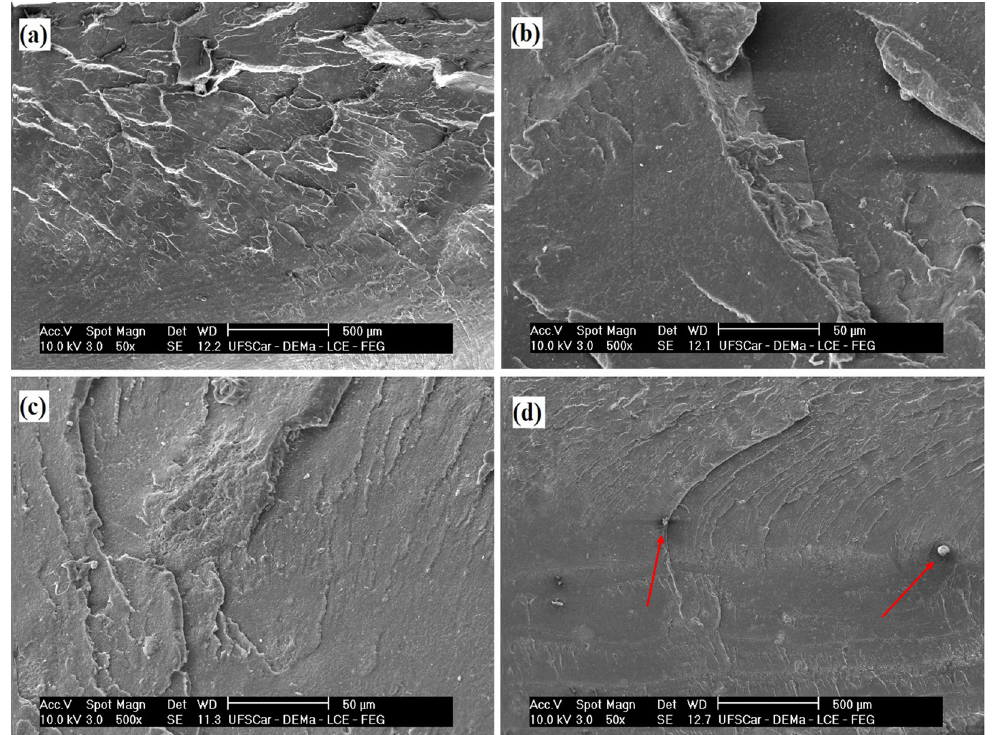
Figure 5. Cryofractured surface SEM micrographs: (a) PLA, (b) PLA/2.5RC, (c) PLA/10RC, (d) PLA/15RC. Table 3. Thermal degradation parameters of the injection molded samples obtained by TGA.